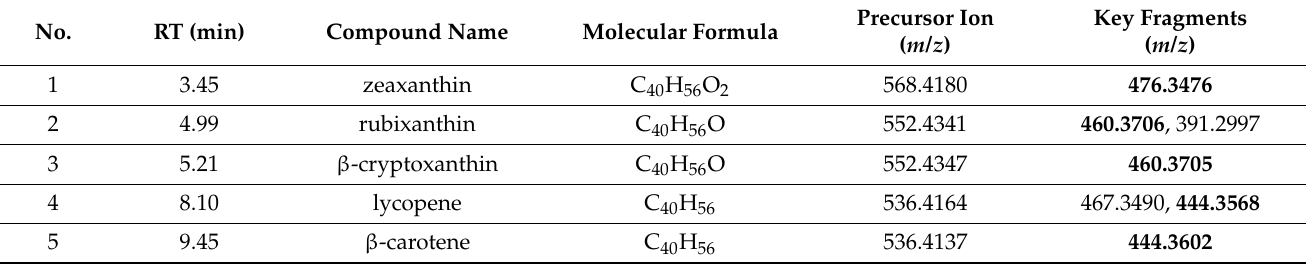
Table 2. Confirmation of the mass spectrometry profile of carotenoids using